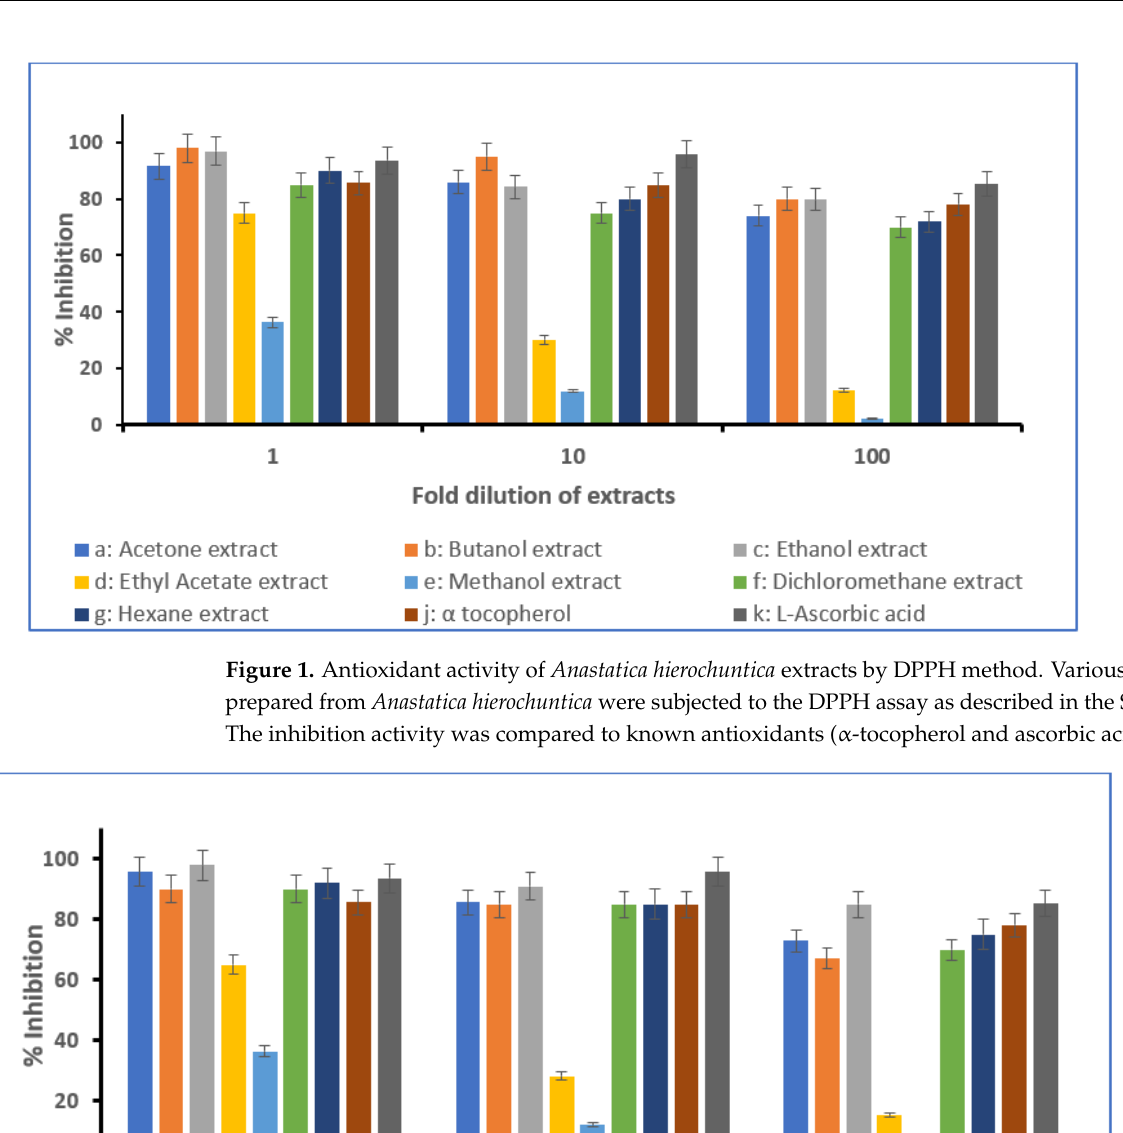
Table 4. The IC 50 values obtained are the lowest (most active) for the ethanol extracts in both plants and the highest IC 50 values were observed in the methanol extracts of both plants (Table 4).